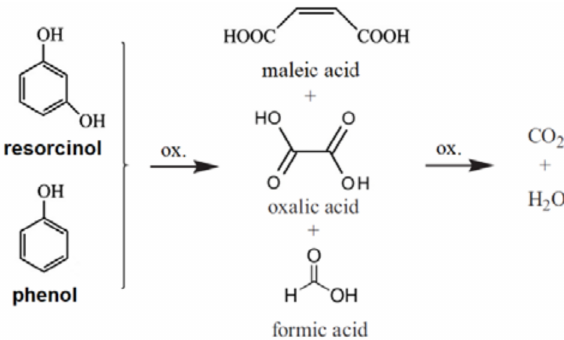
Figure 5. A tentative pathway for phenol and resorcinol